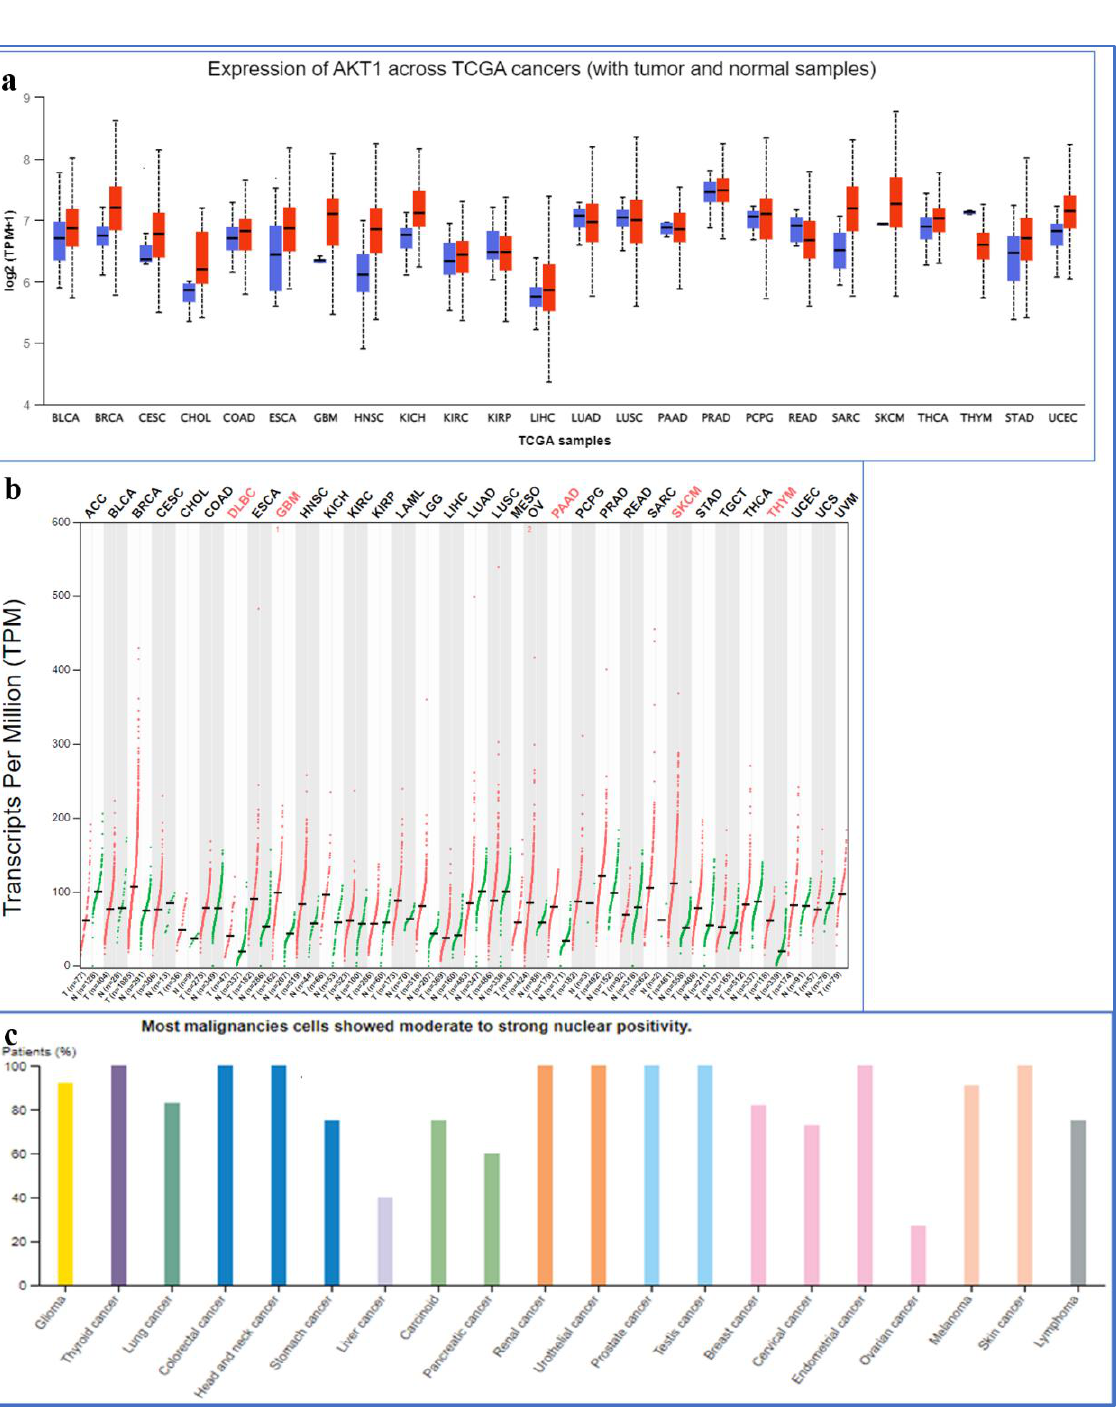
Figure 1. ( a ): AKT1 expression across different cancers according to UALCAN database (blue is for normal and red for tumors), (breast invasive carcinoma (BRCA), cholangiocarcinoma (CHOL), lymphoid neoplasm diffuse large B-cell lymphoma (DLBC), esophageal carcinoma (ESCA), glioblastoma multiforme (GBM), head and neck squamous cell carcinoma (HNSC), kidney chromophobe (KICH), acute myeloid leukaemia (LAML), brain lower-grade glioma (LGG), ovarian serous cystadenocarcinoma (OV), sarcoma (SARC), skin cutaneous melanoma (SKCM) and thymoma (THYM)); ( b ): the gene expression profile (dot plot) across all tumor samples and paired normal tissues according to GEPIA; ( c ): expression of Akt1 in cancer using polyclonal anti-AKT1 antibody HPA002891 (source — Protein Atlas).